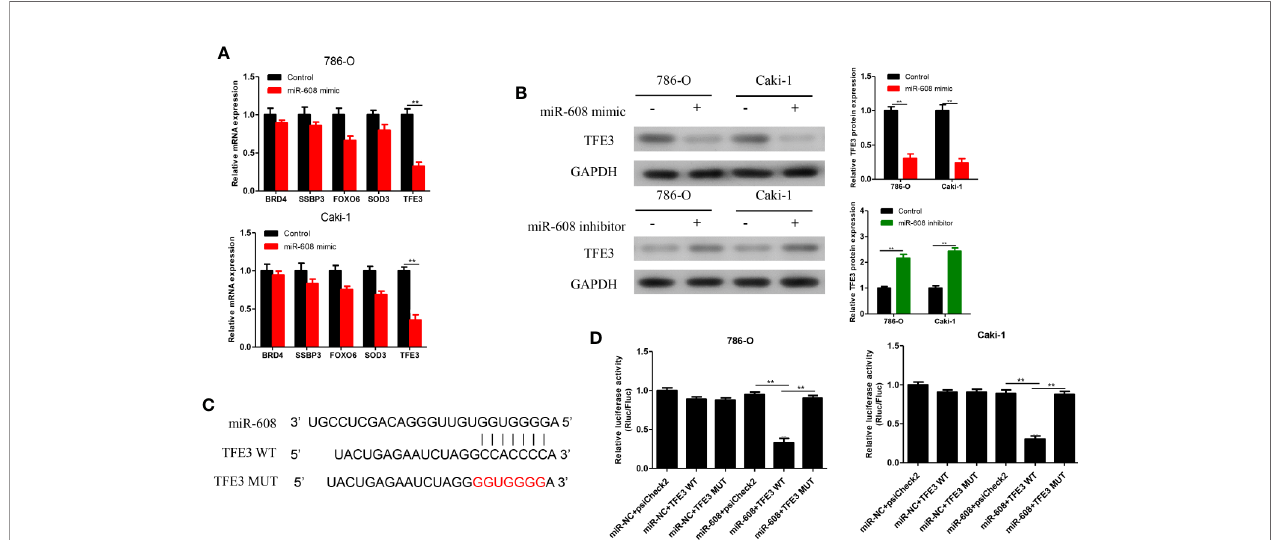
FIGURE 8 | (A) qRT-PCR detected the expression changes of the candidate mRNAs after overexpressing miR-608 in 786-O and Caki-1 cells. (B) Western blot detected the TFE3 protein expression in the 786-O and Caki-1 cells transfected with miR-608 mimic or inhibitor. (C) MiR-608 and TFE3 binding sequences and TFE3 mutated sequences. (D) A luciferase reporter assay was used to verify the direct binding between TFE3 and miR-608. (*** P < 0.001, ** P < 0.01, * P <